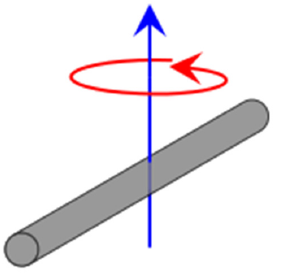
Figure 4. Cylindrical rod object.